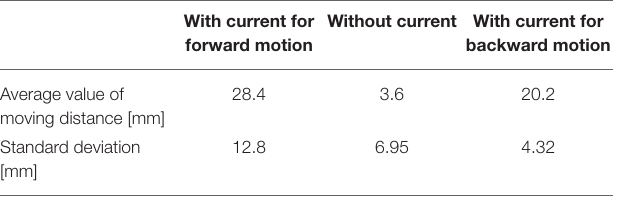
TABLE 2 | The uncertainty analysis of the results of running experiments of the robot with or without current for DN gel. With current for Without current With current for forward motion backward